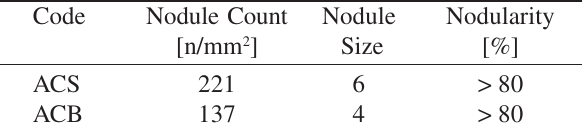
Table 3. Microstructure characteristics.